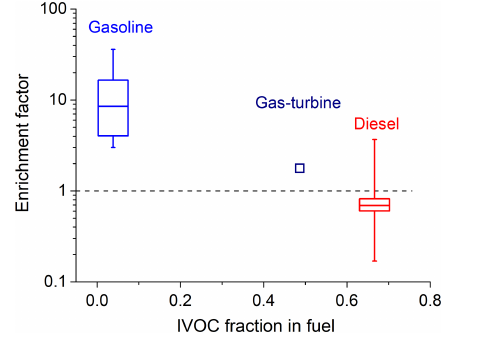
Figure 6. IVOC mass enrichment factors as a function of IVOC content in fuel, R Enrichment ,i = (m exhaust /m exhaust )/(m fuel /m fuel ) . The box-whisker plots i C 8–10 i C 8–10 indicate variability in ratio within a given source class: 25th–75th percentiles and 10th–90th